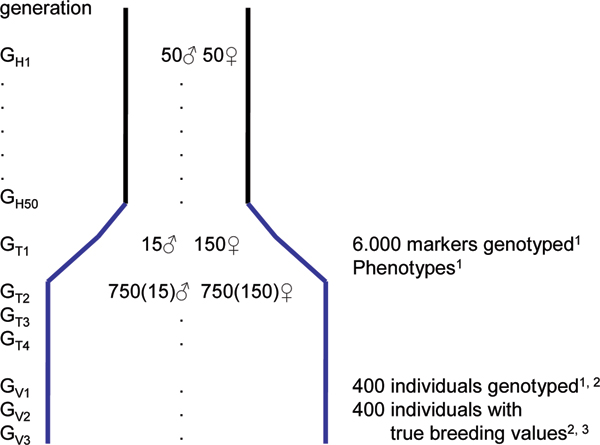
Design of the simulation study. 1Data provided to participants. 2400 individuals sampled randomly in each generation from population of 1500. 3True breeding values known only to organisers for validation. Numbers in parenthesis is the number of parents for the next generation.